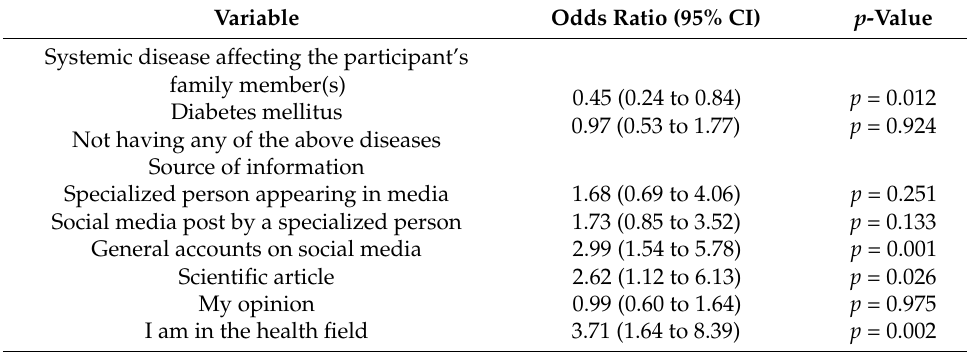
Table 16. Multivariate analysis for the association between periodontal disease and respiratory tract